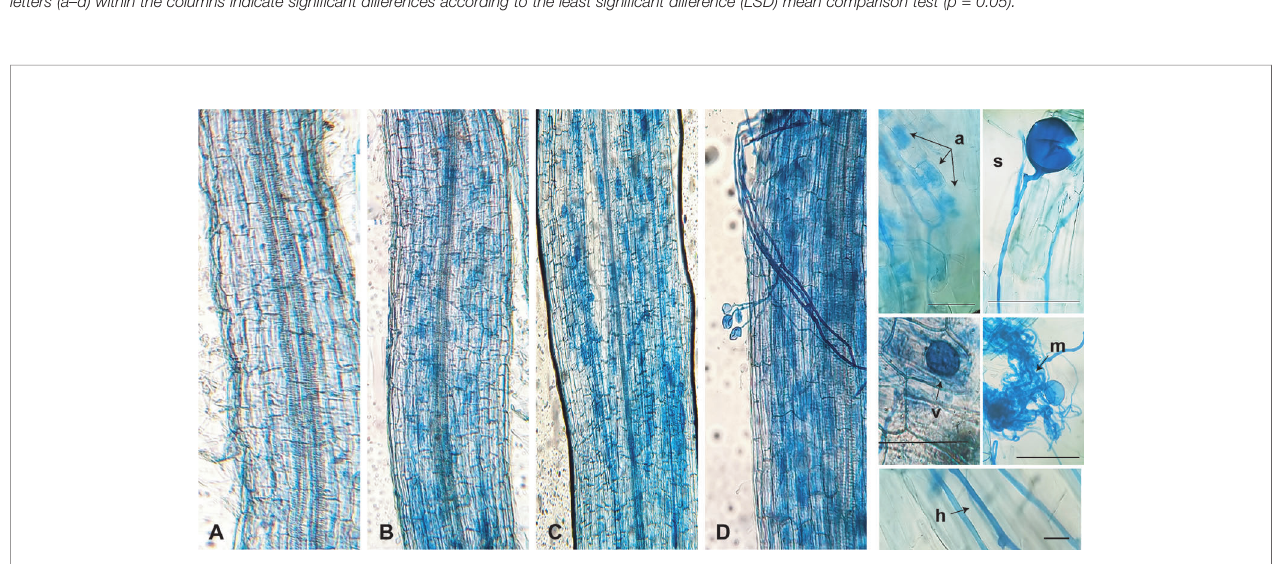
FIGURE 4 | Optical micrographs of the tomato roots and morphological structures of Rizophagus intraradices during mycorrhizal symbiosis (A) Non-arbuscular mycorrhizal fungi (AMF) in root, (B) AMF in root, (C) AMF in root and irrigated with nutritive solutions (AMF + SN), and (D) AMF in root with seaweed extract and irrigated with nutritive solution (AMF + SE + NS). Spore (s), hyphae (h), mycelium (m), arbuscule (a), vesicle (v). Scale bars represent 200 µm 40×. (n = 6 plants). TABLE 4 | Rizophagus intraradices colonization measured on the tomato root system. AMF colonization of the root system (M%) and arbuscule abundance (A%) and relative expression values of symbiosis marker genes. Treatment